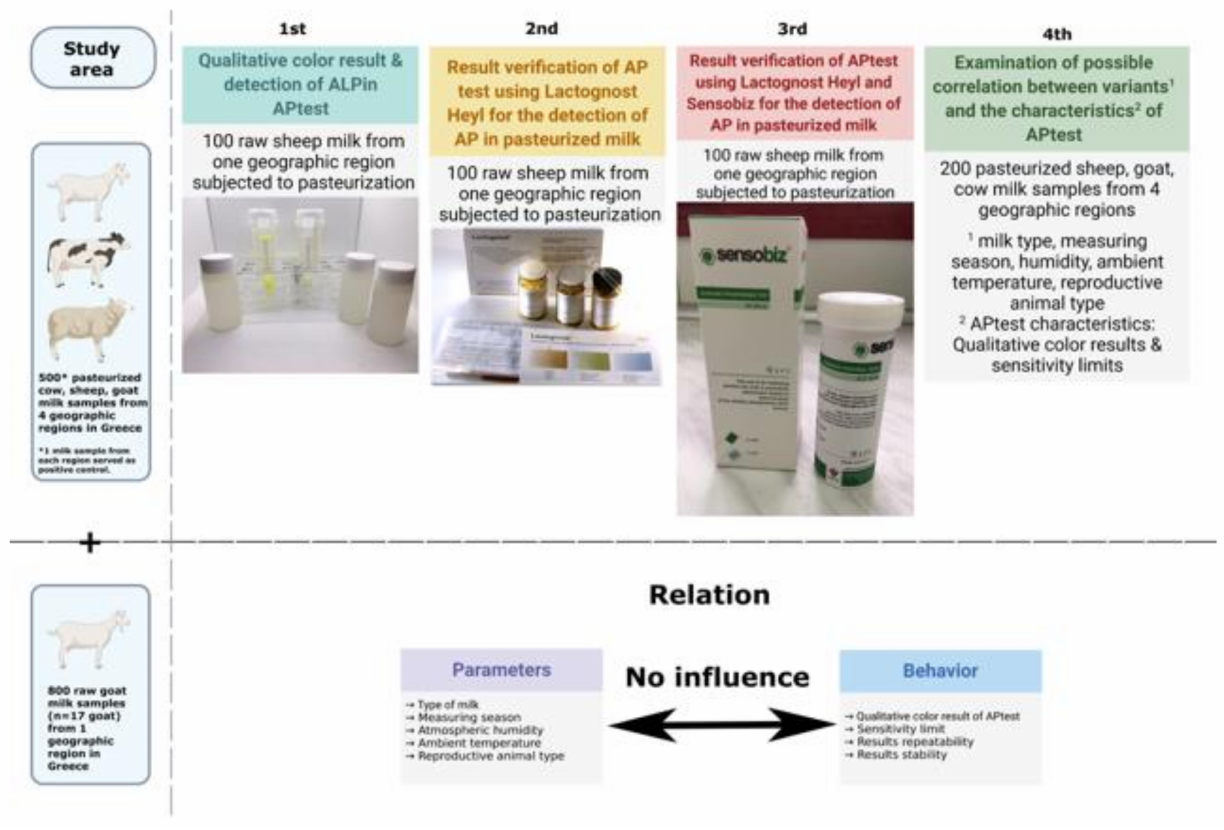
Figure 1. The workflow of the present study